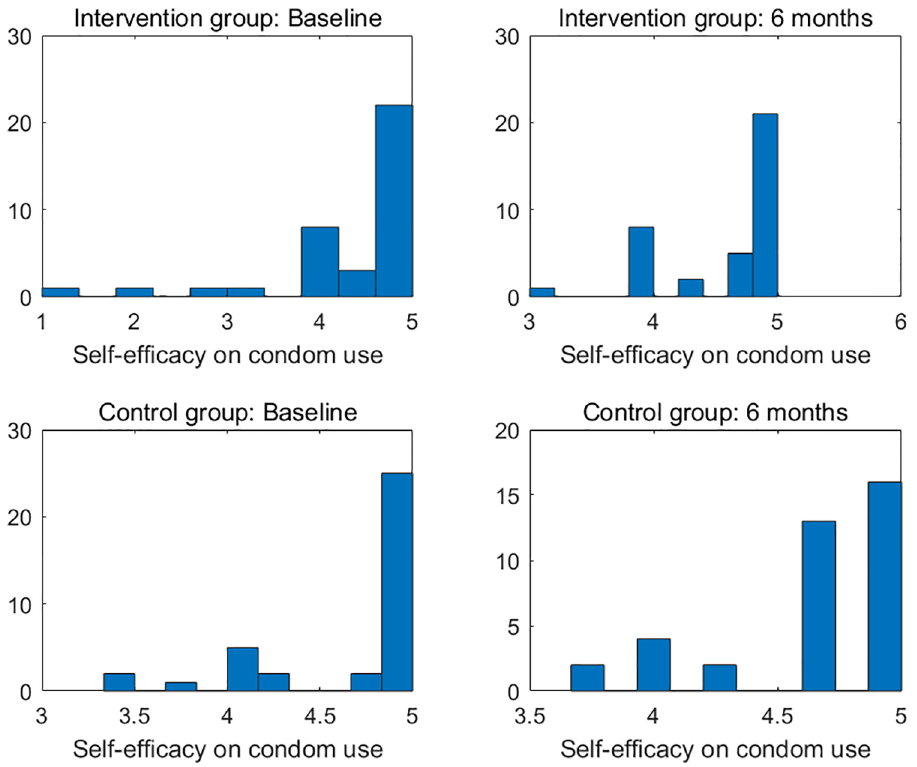
Fig 3. Histograms of self-efficacy on condom use for treatment and control groups at baseline and 6-month visits.